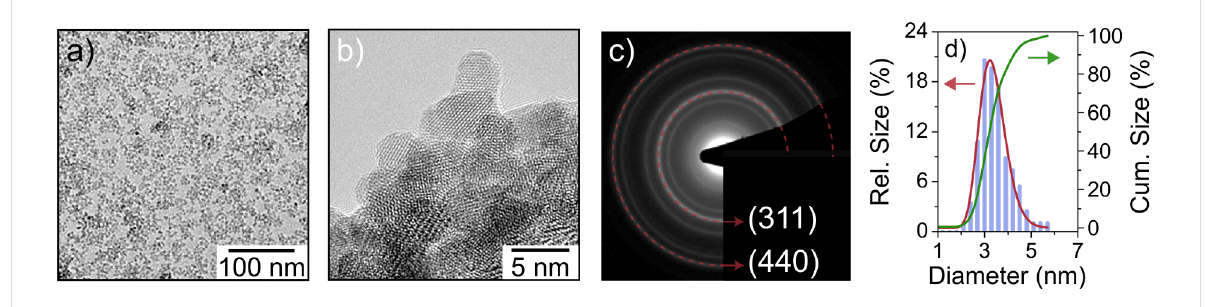
Figure 1: Electron microscopy of as-prepared ZFO nanoparticles. (a) Bright-field TEM image. (b) HRTEM image and (c) SAED pattern demonstrating the crystallinity. Note that only the most intense diffraction rings are indexed in (c). (d) Relative and cumulative particle size distributions. The red line is a log-normal fit to the